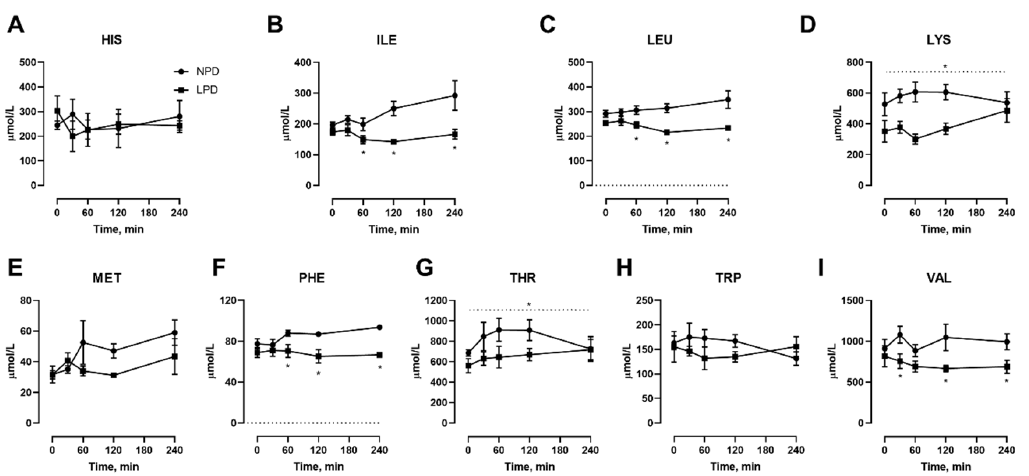
Figure 4. E ff ects of dietary protein restriction on blood serum essential amino acids during isocaloric meal feeding. Young men ( n = 5) underwent a 7 d period of consuming a protein-restricted diet, with isocaloric meal tolerance tests conducted before and at the end of the 7 d period, with blood samples drawn at selected time points during the test. Blood serum amino acid levels including histidine ( A ), isoleucine ( B ), leucine ( C ), lysine ( D ), methionine ( E ), phenylalanine ( F ), threonine ( G ), tryptophan ( H ) and valine ( I ) were measured. NPD: normal-protein diet; LPD: low-protein diet. Data are the mean ± SEM. Two-way RM ANOVA, di ff erent than NPD: * p < 0.05. A dotted line over the entire data indicates a main e ff ect of diet.